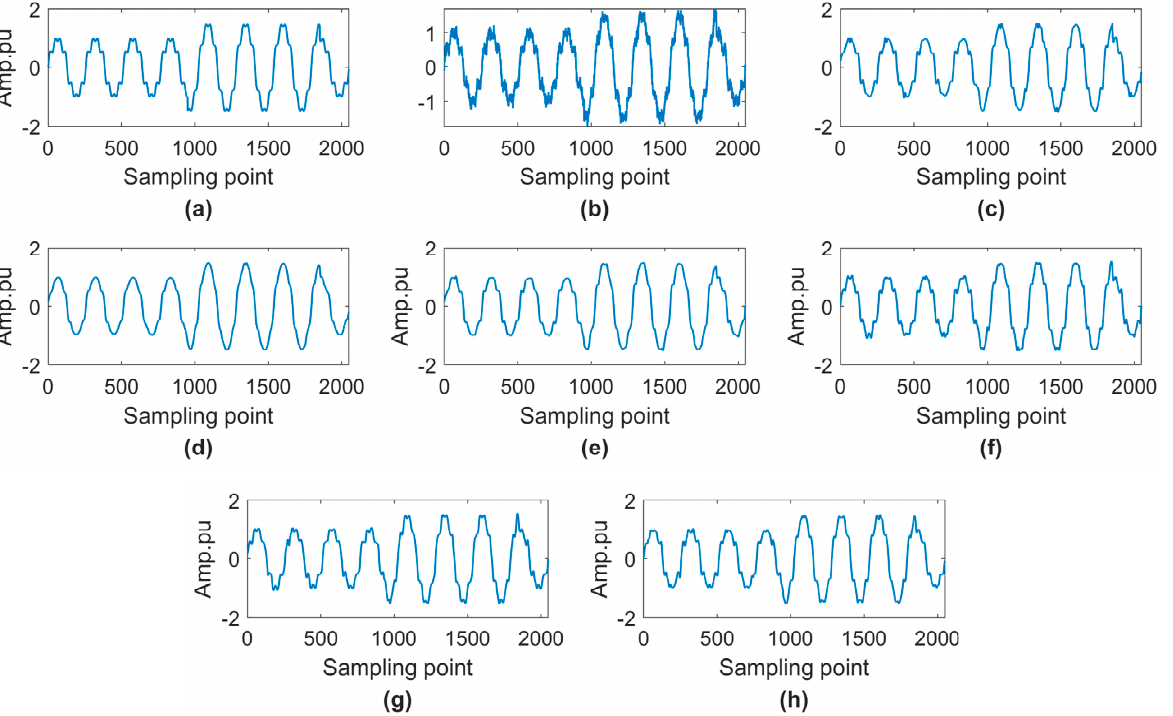
Figure 7. ( a ) Noiseless harmonics with swell; ( b ) harmonics with swell and a SNR of 20 dB; ( c ) hard thresholding denoising; ( d ) soft thresholding denoising; ( e ) denoising following the method described in Ref. [1]; ( f ) denoising following the method described in Ref. [2]; ( g ) denoising following the method described in Ref. [27]; ( h ) denoising following the proposed method processing.